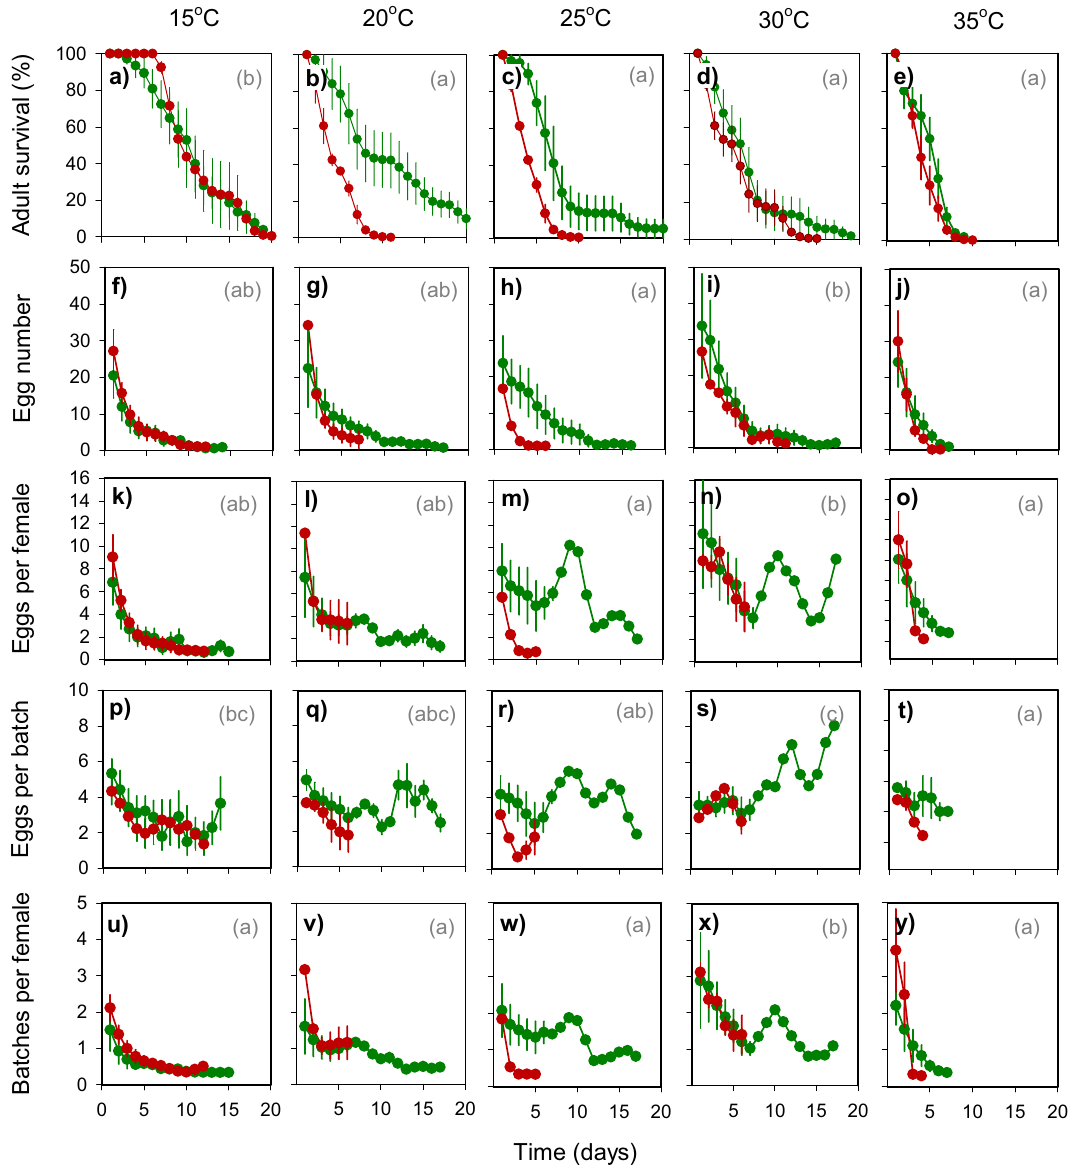
Figure 1. Daily survival and egg-laying by Nilaparvata lugens on susceptible (IR22: green circles) and resistant (IR62: red circles) rice varieties. Plants were grown at 15 °C ( a,f,k,p,u ), 20 °C ( b,g,l,q,v ), 25 °C ( c,h,m,r,w ), 30 °C ( d,i,n,s,x ) and 35 °C ( e,j,o,t,y ). Relative humidity was maintained at 80%. Results for Adult longevity ( a–e ) and the total number of eggs deposited ( f–j ) are indicated. The number of eggs per surviving female ( k–o ), the size of egg batches ( p–t ) and the number of batches produced per female ( u–y ) are indicated as components of egg- laying displaying three oviposition cycles on IR22 between 15 and 30 °C. Standard errors are included (N = 4). Lowercase letters indicate homogenous temperature groups for each parameter (Tukey: P ≤